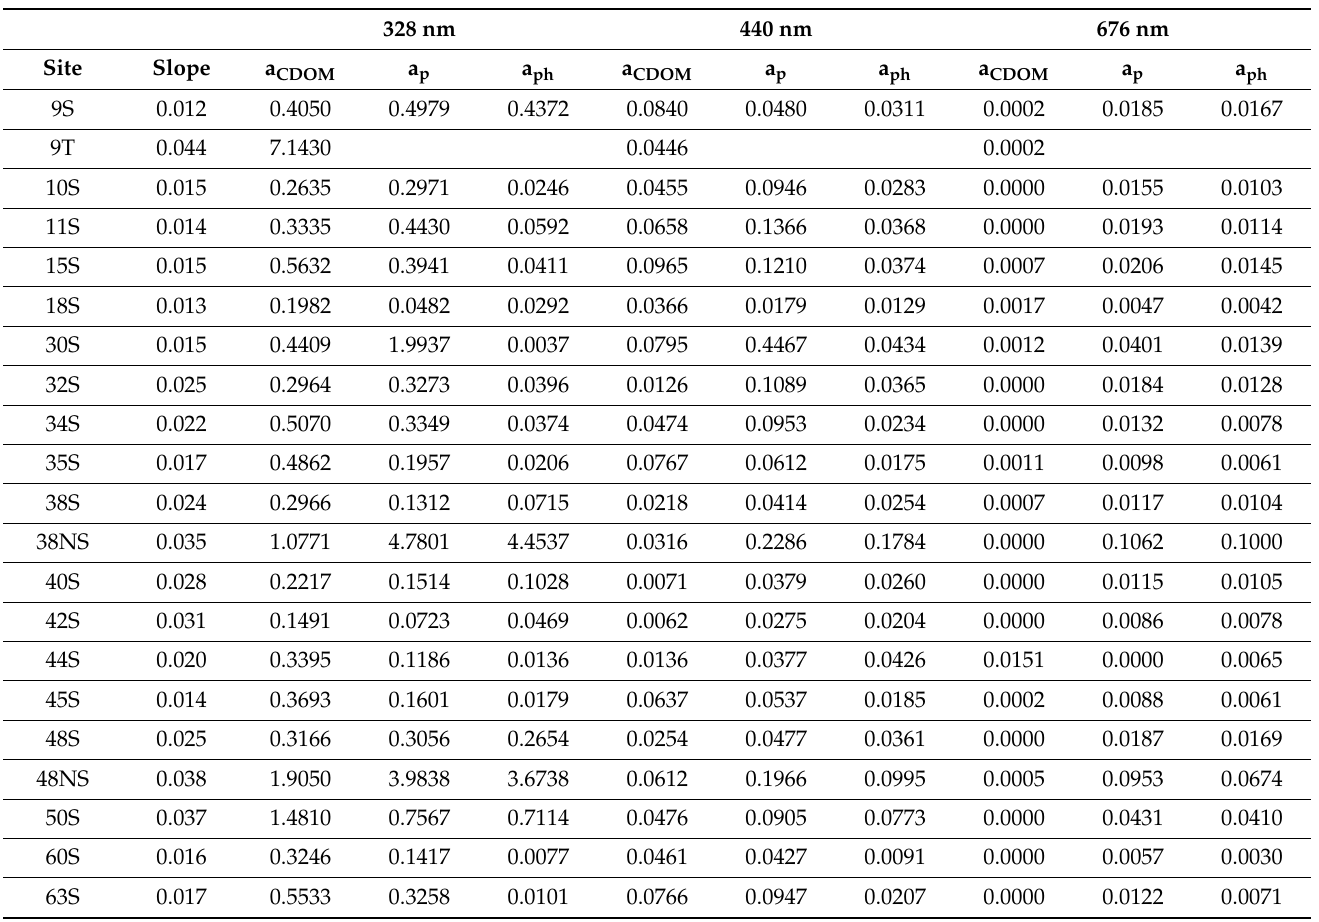
Table 2. Absorption coefficients (m − 1 ) at 328 nm, 440 nm and 676 nm and the spectral slope (CDOM) for samples from Keppel